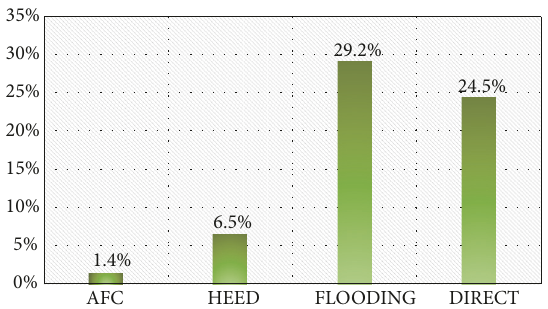
Figure 9: The degree of energy imbalance in different schemes.